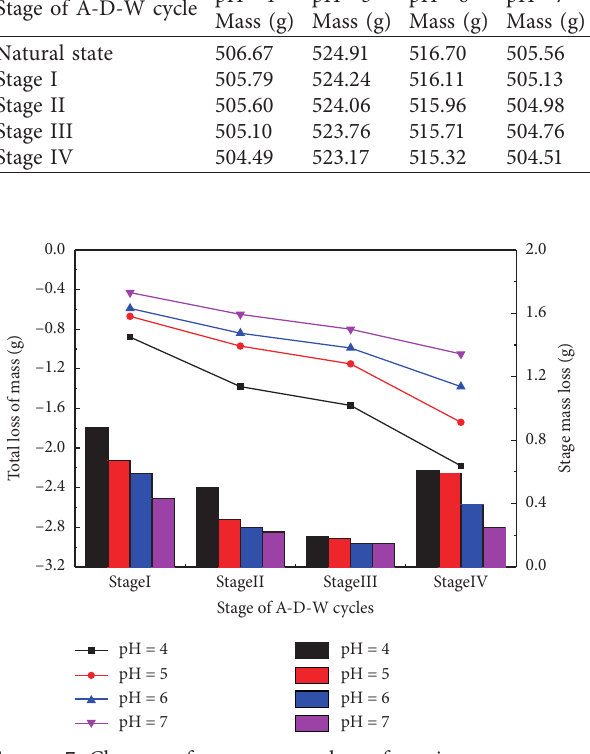
Figure 7: Changes of average mass loss of specimens versus so- lutions pH and A-D-W